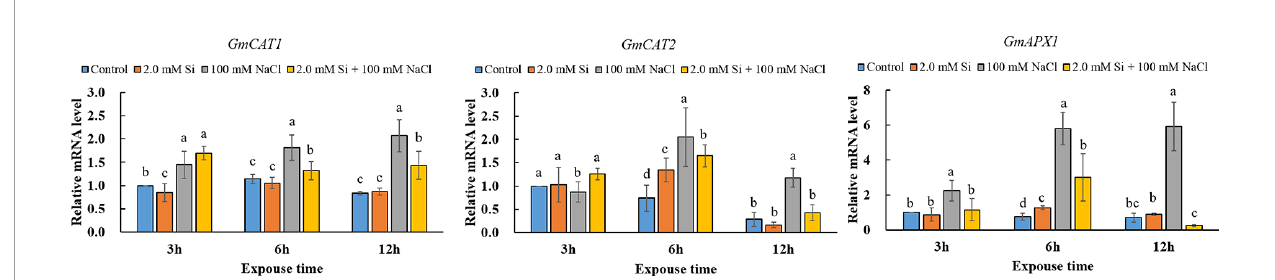
FIGURE 5 | Relative messenger mRNA expression level of antioxidant-related genes ( GmCAT1 , GmCAT2 , GmAPX1 ) after single or combined Si and NaCl. Data were collected at 3, 6, and 12 h after stress exposure. Different letters above error bars indicate signi fi cant differences by Duncan's multiple range test ( P < 0.05). Data were collected in triplicate and are presented as the average ± standard error ( n = 3).